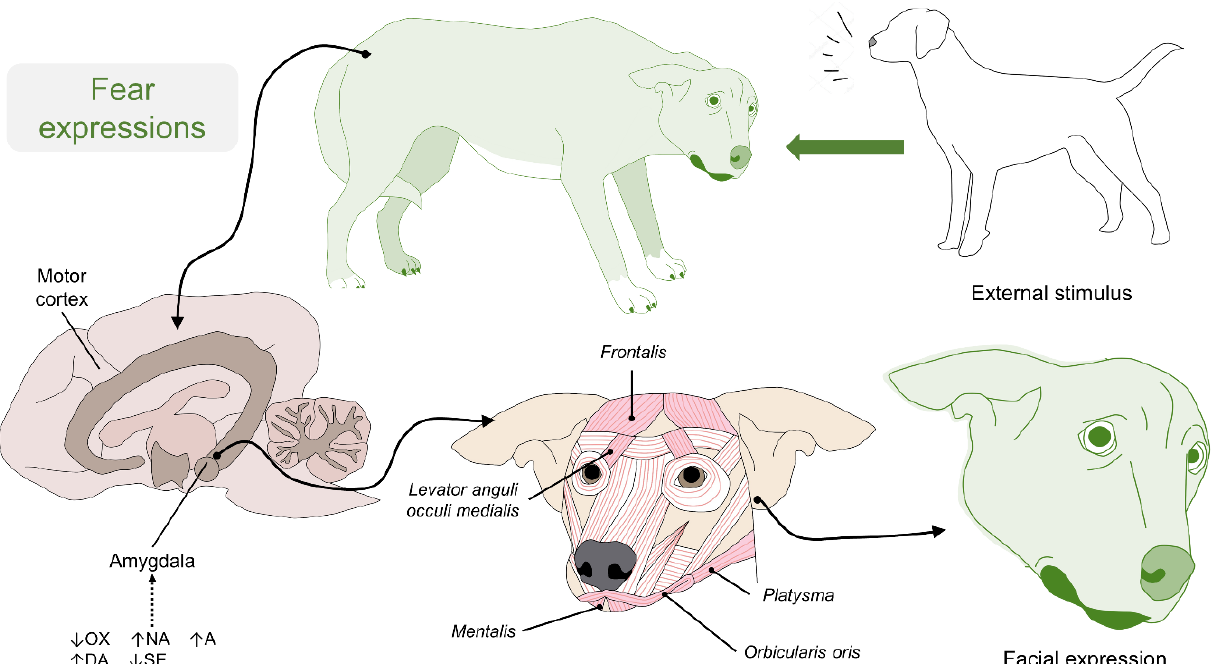
Figure 3. Neurobiology of facial expression in dogs. During a threat exposure, such as another dog, unfamiliar person, or a dispute over territory, the neural mechanism in the amygdala reacts to catecholamine secretion (A and NA). The catecholamines stimulate the motor cortex and its efferent fibers to modify a facial expression. Movements such as flattening the ears to the side (EAD105) and lifting the upper eyelids to have a wider field of vision (AU101) are characteristic of an expression of fear. OXT: oxytocin; NA: noradrenaline; A: adrenaline; DA: dopamine; SE: serotonin.